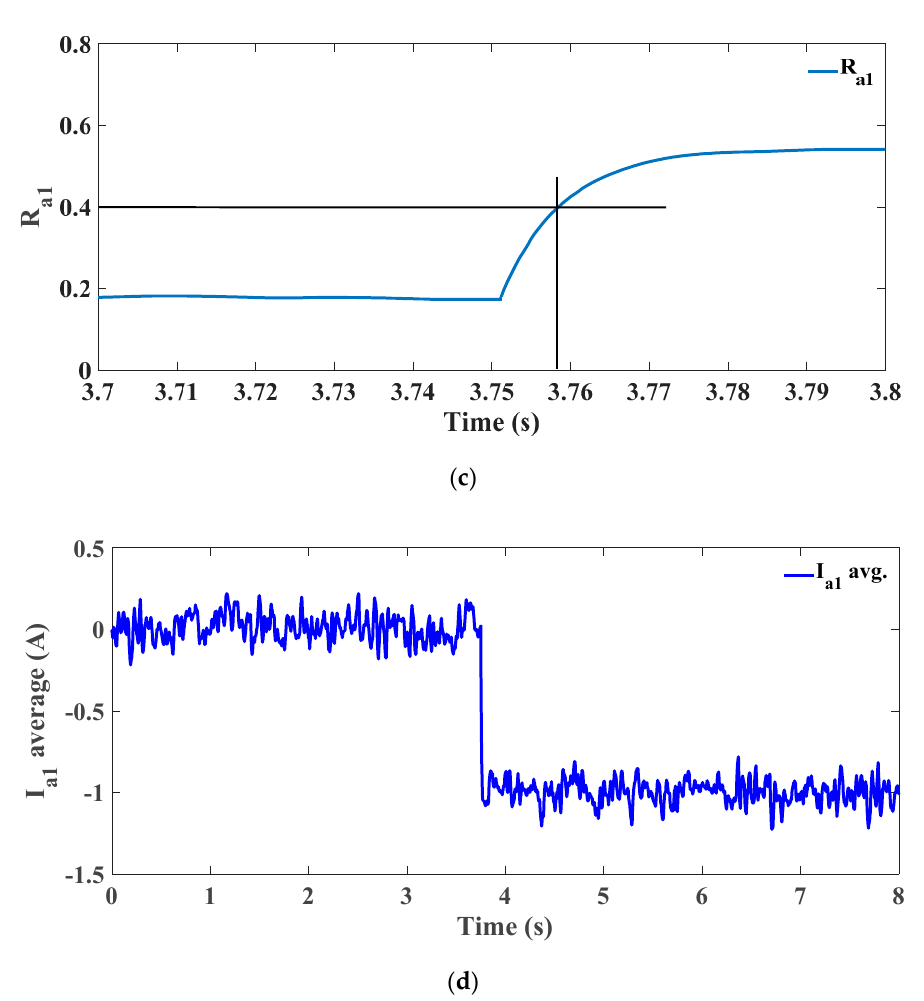
Figure 8. OSF test: ( a ) Phase current (a1); ( b ) Ra1 index; ( c ) Ra1 index (zoom-in); ( d ) Iph_avg.